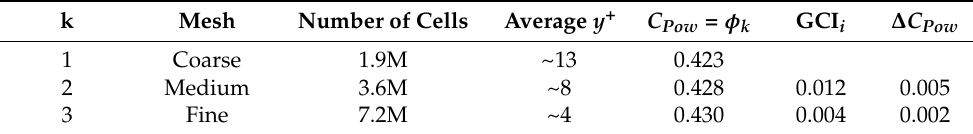
Table 1. Convergence analysis results for C Pow .